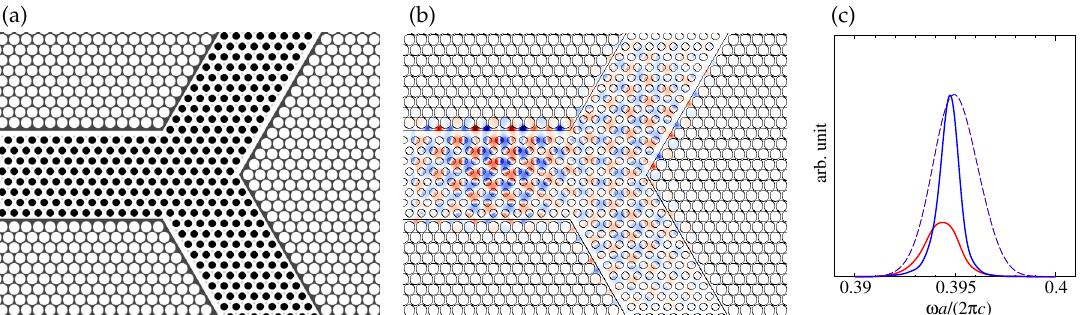
Figure 3. ( a ) Y-shaped waveguide composed of the photonic crystal in Figure 2. The relative permittivity of the gray region of block layer around the waveguide is set to be 9. ( b ) z -component of magnetic field H z . ( c ) Spectra of the transmissions to the upper right (blue line) and to the lower right (red line) branches. The broken lines represent the transmission spectra for a vacuum Y-shaped